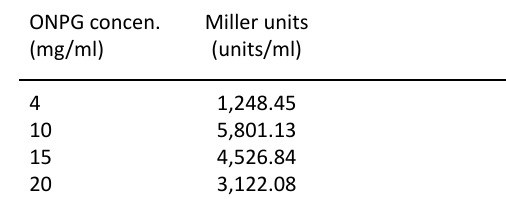
Table 4. Effect of ONPG concentration on enzyme activity by L. fermentum